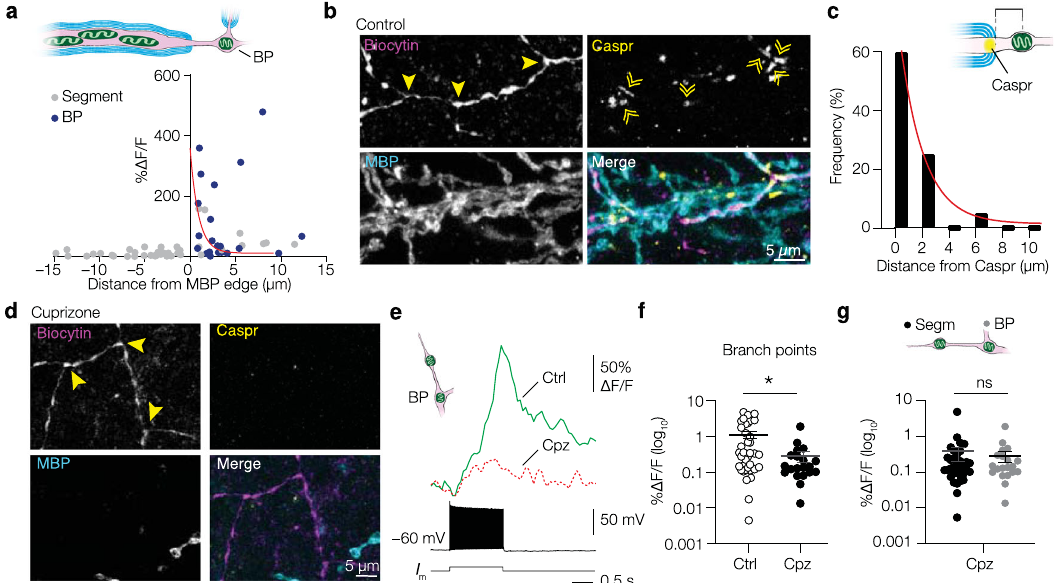
Fig. 8 | The mt-Ca 2+ responses are ampli fi ed at nodal domains in PV + axons. a Relation between distances from myelin sheaths and mt-Ca 2+ response ampli- tude. Red line indicates exponential decay fi t ( y =(3.588 – 0.1117)×exp( − 0.894× x )+0.1117); n =62mitochondriaof9cellsfrom6mice). b Exampleconfocalimages of PV + axon branch points fl anked by paranodes (Caspr). Similar results were obtained in 3 mice. c Mitochondria are frequently found close to paranodes. Red line indicates exponential decay fi t ( y =(60.73 – 1.415)×exp( − 0.5692× x )+1.415); n =20mitochondriaof4cellsfrom3mice. d ExampleofPV + axonbranchpointsof a cuprizone-treated mouse. Notice the overall lack of both MBP and Caspr immunostaining. Similar results were obtained in 3 mice. e Left: schematic repre- sentation of the compartments investigated in ( e ) and ( f ); Right: example traces